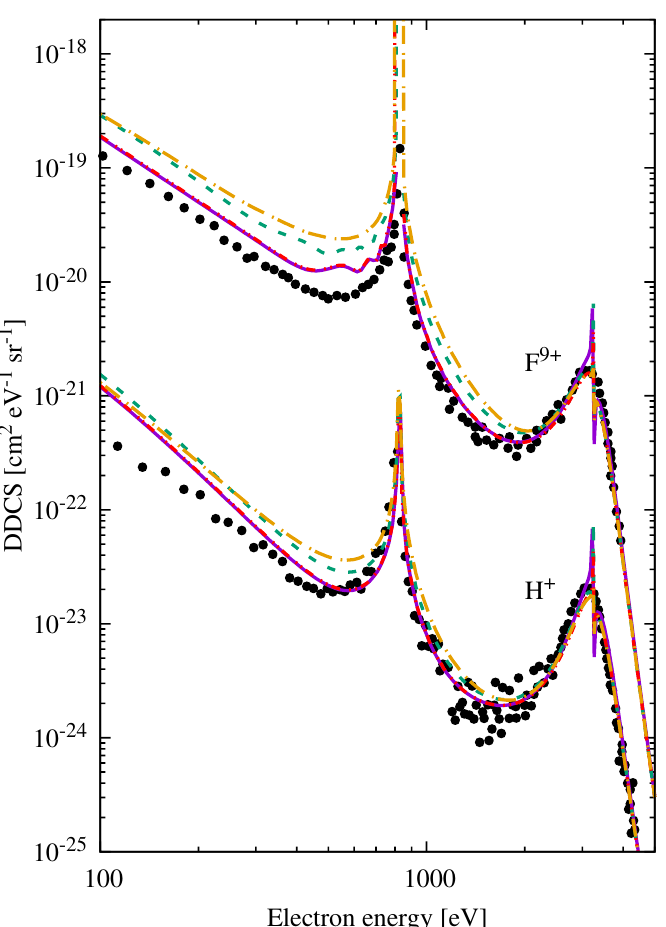
Figure 1. Double differential cross-section for the single ionization of He atoms by 1.5 MeV/u F 9 + and H + impact as a function of the electron energy for a 0 ◦ fixed emission angle. Theory: full-line prior CDW integrated with a 20-point Gauss quadrature; dashed-double-dotted-line, complete post CDW integrated with a 20-point Gauss quadrature; dashed-line, complete post CDW integrated with a 60-point Gauss quadrature; dashed-dotted-line, complete post CDW integrated with QUADPACK library; experiments, circles